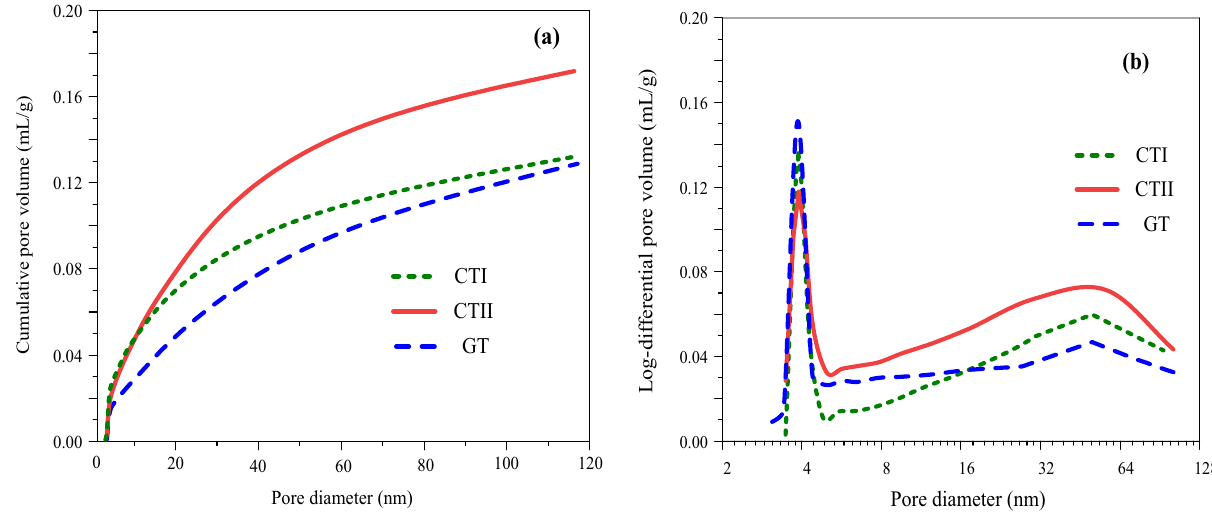
Figure 15. Effect of mineral content on nitrogen adsorption test results of